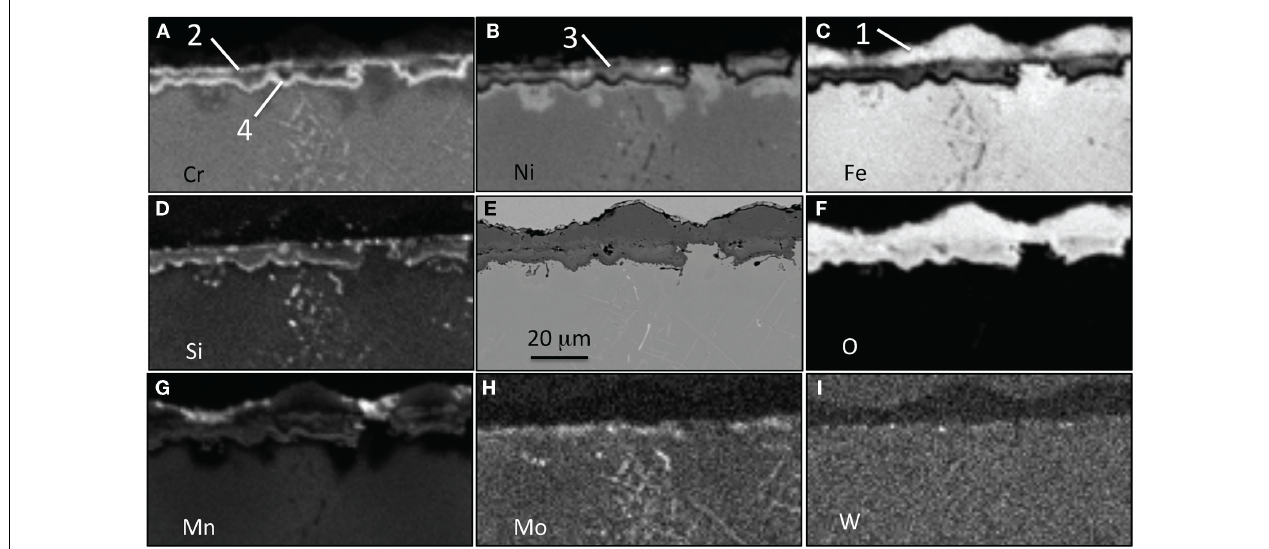
FIGURE 6 | EPMA mapping for alloy 22Cr–17.5Ni after exposure for 5000h in air +++ 10% H 2 O at 700°C, (A) Cr, (B) Ni, (C) Fe, (D) Si, (E) SEM picture, (F) O, (G) Mn, (H) Mo, and (I) W . Four different oxide layers are labels.